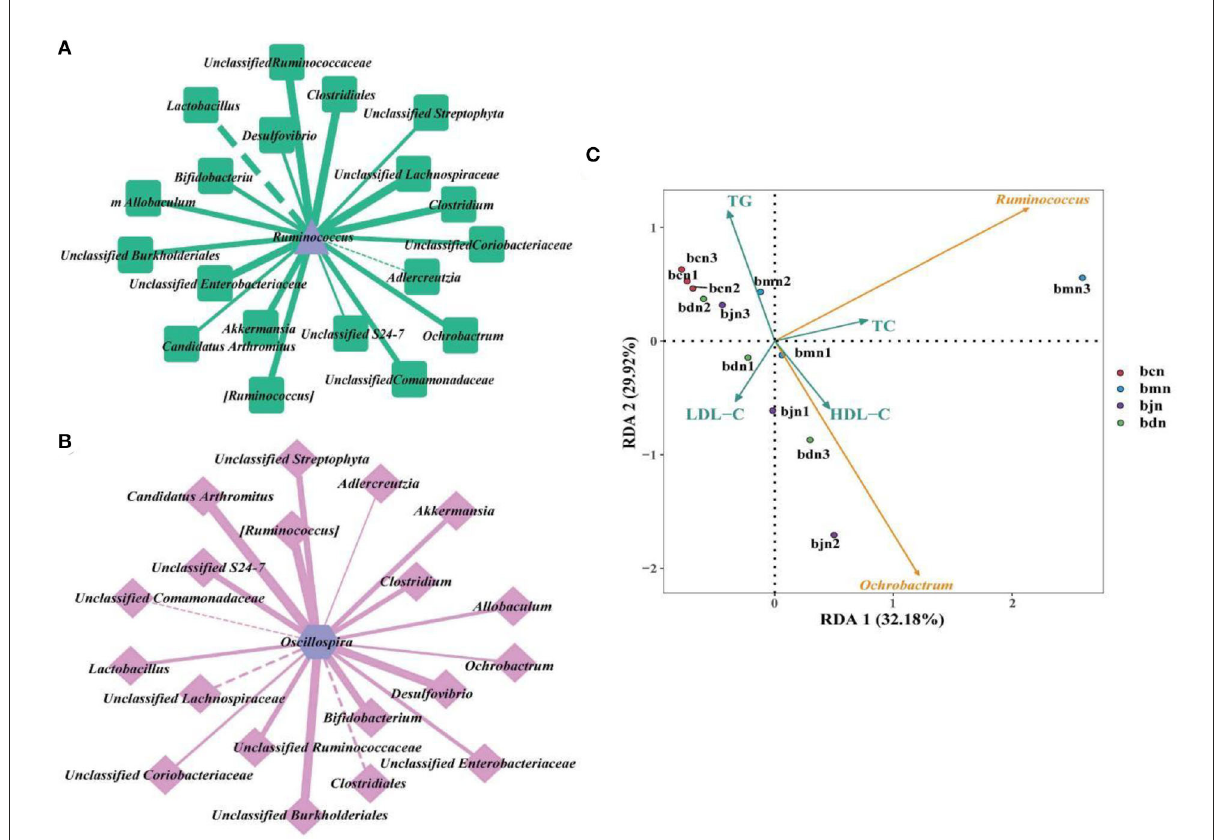
FIGURE7 Correlation analysis. (A) “ Ruminococcus -dominant bacteria” interaction network at the genus level. (B) “ Ochrobactrum -dominant bacteria” interaction network at the genus level. Solid line represented positive correlation, dotted line represented negative correlation. The thickness of the line indicated the strength of the correlation. (C) RDA analysis. Different colored arrows represented the dominant bacteria and environmental factors. Dots of different colors represented samples from different groups. The Angle between the arrow lines represented correlation, an acute angle represented positive correlation, and an obtuse angle represented negative correlation. bcn: normal saline-treated basal diet group; bmn: normal saline-treated high-fat diet group; bdn: DO traditional decoction-treated high-fat diet group; bjn: lipid-lowering decoction-treated high-fat diet